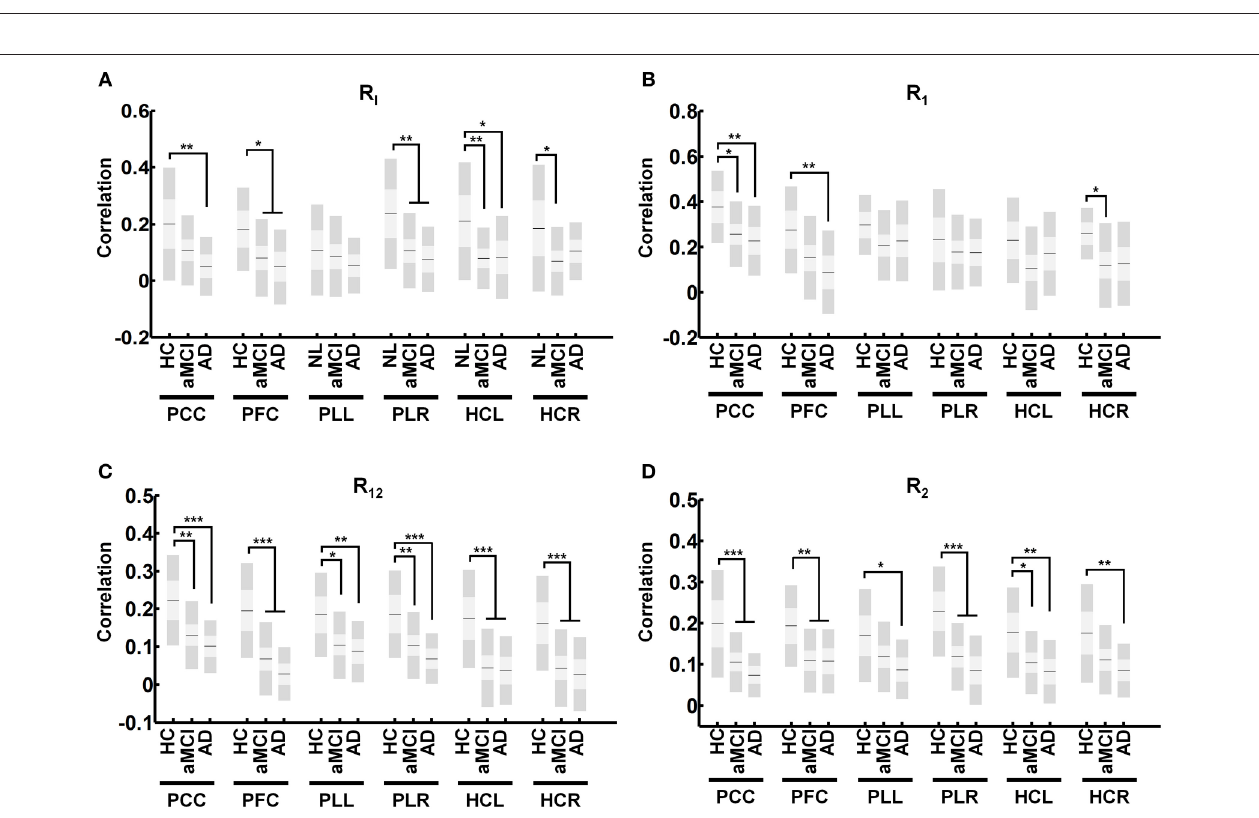
FIGURE 5 | Average connectivity for each region of the DMN for derived measures. Average calculated connectivity for R I (A) R 1 (B) , R 12 (C) , and R 2 (D) in each region shows R 12 and R 2 connectivity to be universally affected in regions of the DMN while R 1 connectivity remains relatively intact. Graph shows mean, SD, and 95% confidence intervals. Lines with asterisks show which groups demonstrated statistical differences: * α < 0.05, ** α < 0.01, *** α < 0.001. Only connections that are significant after FDR correction for multiple comparison are shown ( α <